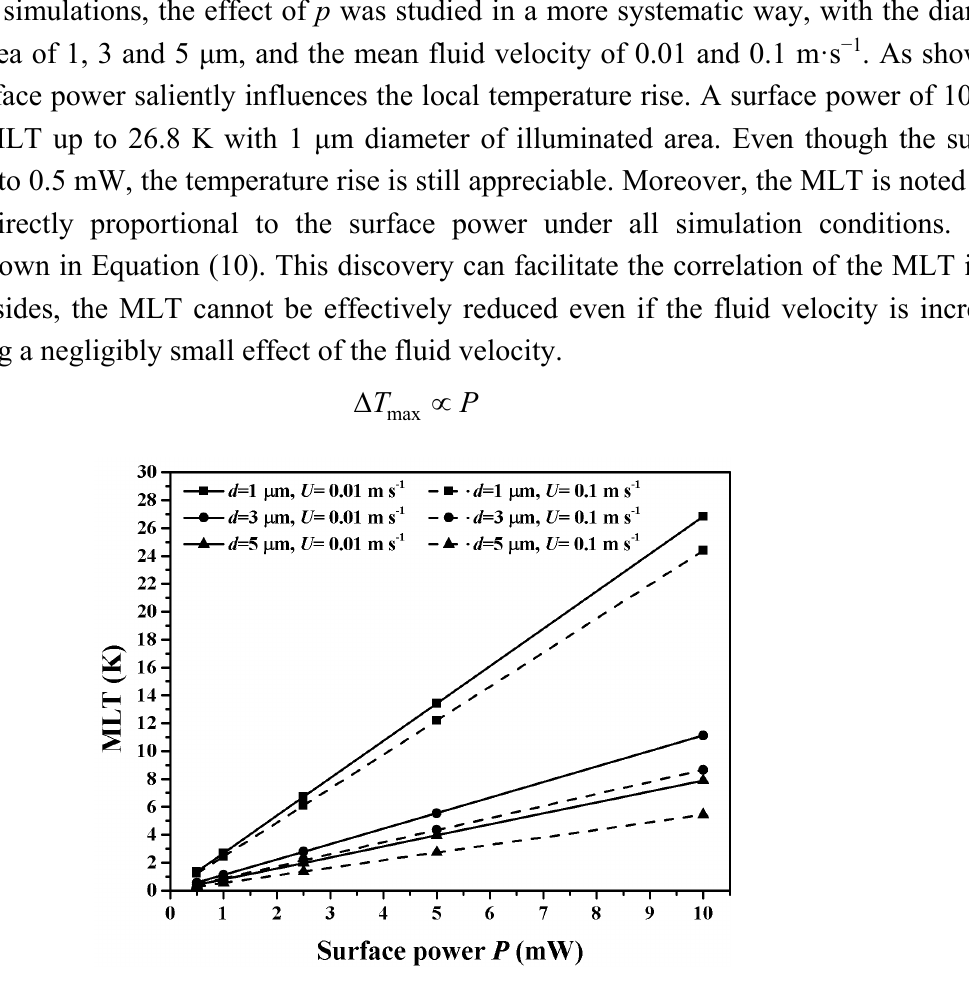
Figure 5. Effect of the surface power at the mean velocity of 0.01 m·s − 1 (solid line) and 0.1 m·s − 1 (dashed line) when the diameter of illuminated areas are 1 μ m ( ■ ), 3 μ m ( ● ) and 5 μ m ( ▲ ), respectively. The microchannel is 800 μ m wide, 30 μ m high and 10 mm long. The chip is 10 mm wide, 0.4 mm thick and 10 mm